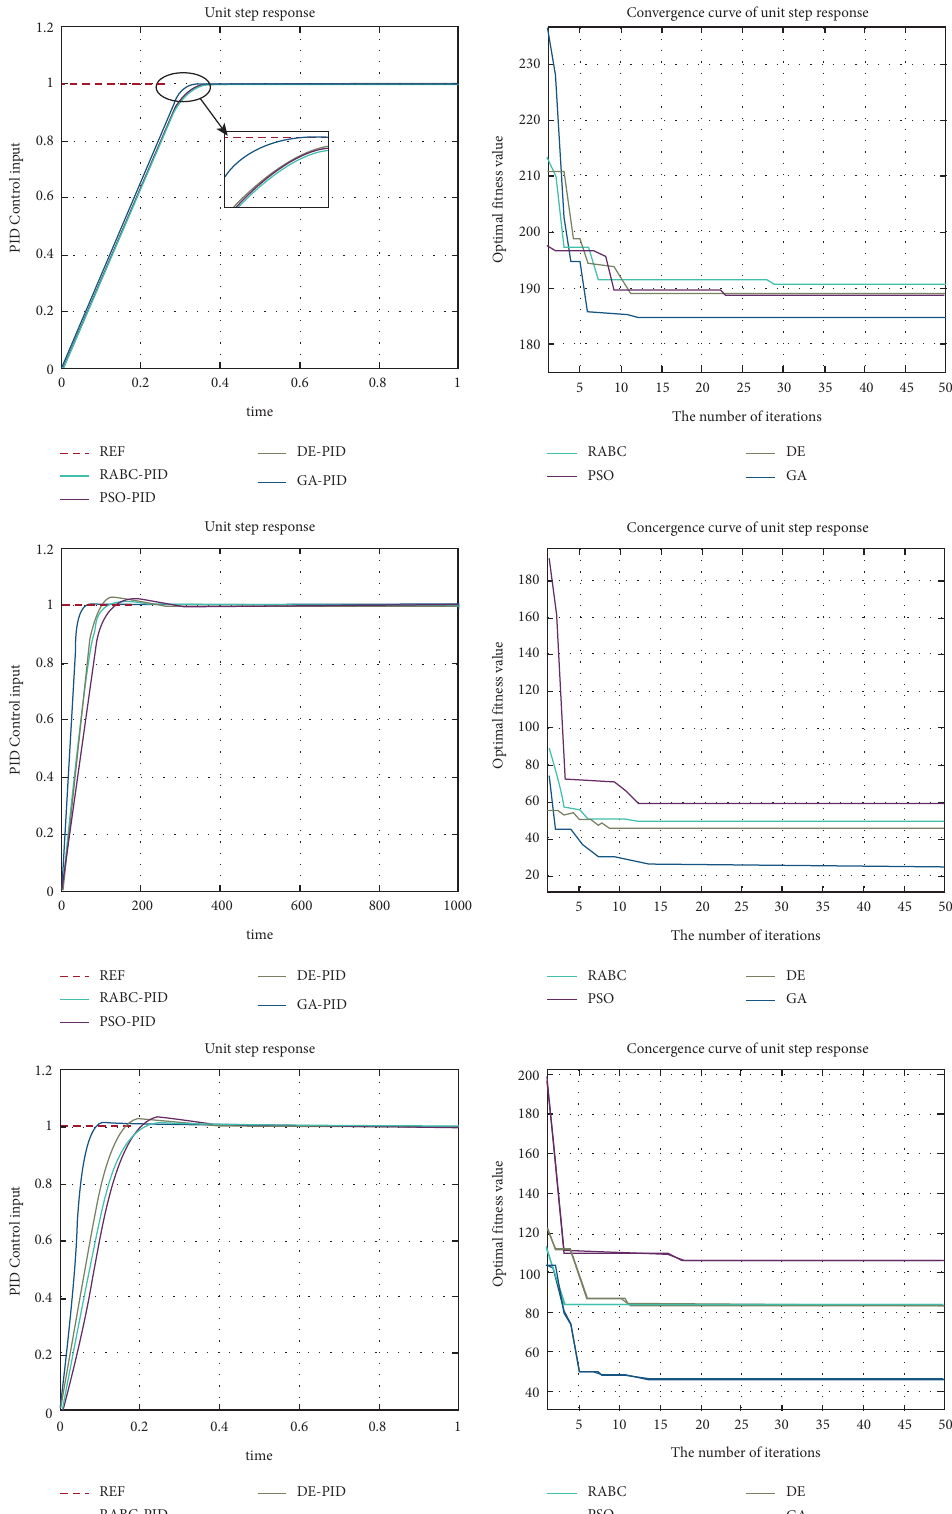
Figure 9: Unit step response curve and convergence curve when the parameters T � 15, T